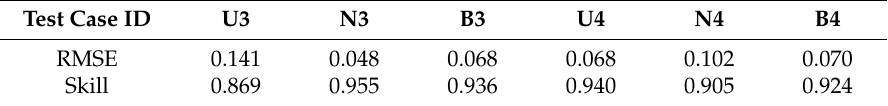
Table 2. Root mean square error (RMSE) and skill factor of the normalised wave